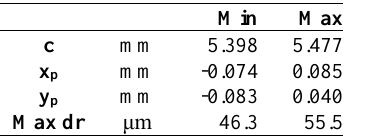
Table 3: Extract of the min and max values for the main IO Figure 4: Position of the principal point in mm for each band – parameters results for the first trial (●) and the second trial (+) Figure 5 shows the Gaussian radial distortion plots for the five bands for the two sets of calibrations. The dashed vertical lines represent the maximum radial distance used in each image by